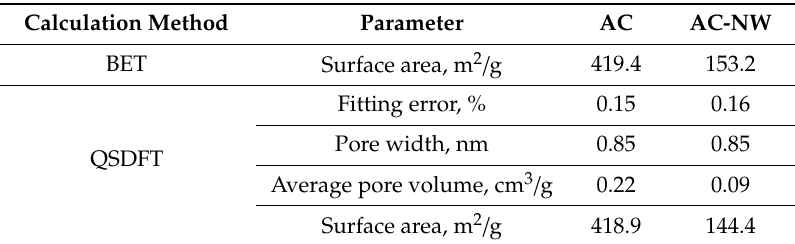
Table 3. Textural properties of AC and AC-NW composite.